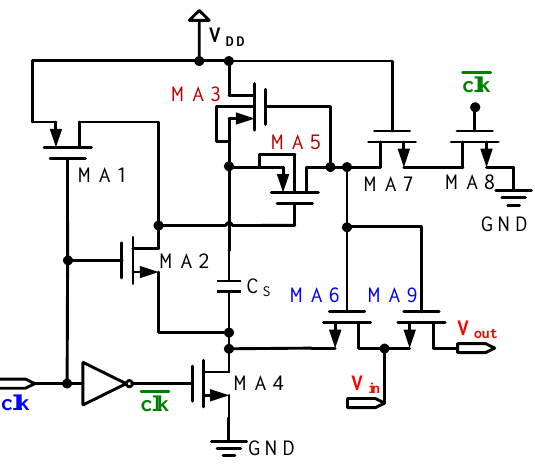
Figure 4. Schematic of the proposed sample and hold circuit. Table 2. Simulated results of the proposed S/H circuit with five design corners.